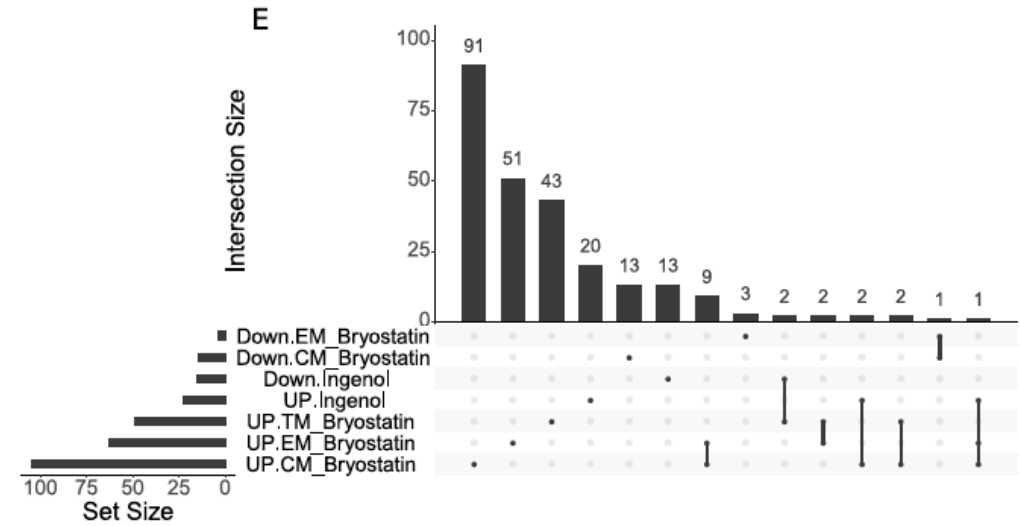
Figure 2. Differential expression of transposable elements in CD4+ T cells treated with Bryostatin and PMA. Volcano plots for each memory CD4+ T-cell subset are shown for Bryostatin ( A ) and PMA treatment ( B ). Venn plots depict commonly and exclusively regulated TEs for Bryostatin ( C ) and PMA ( D ). ( E ) UpSet plot for up- and downregulated TEs in memory T CD4+ treated with Bryostatin and Ingenol